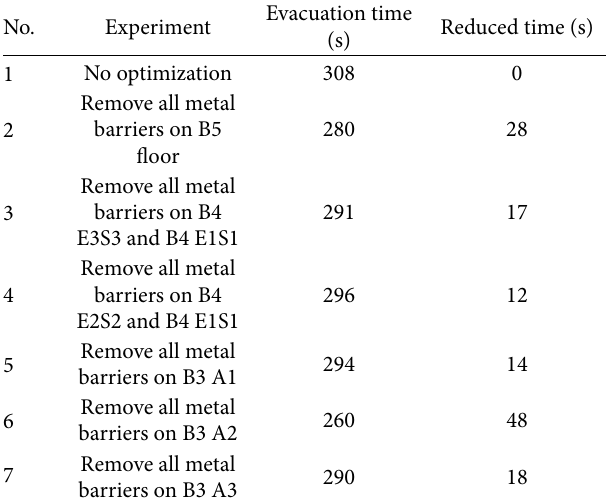
Table 4: Optimization results of the six experiments.